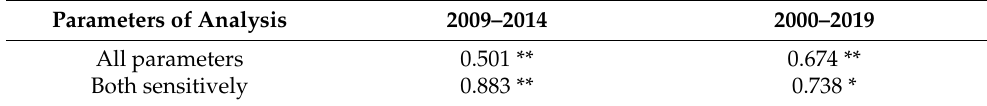
Table 3. Correlation coefficients between the Morris method ( µ * ) and EFAST ( ST i ).